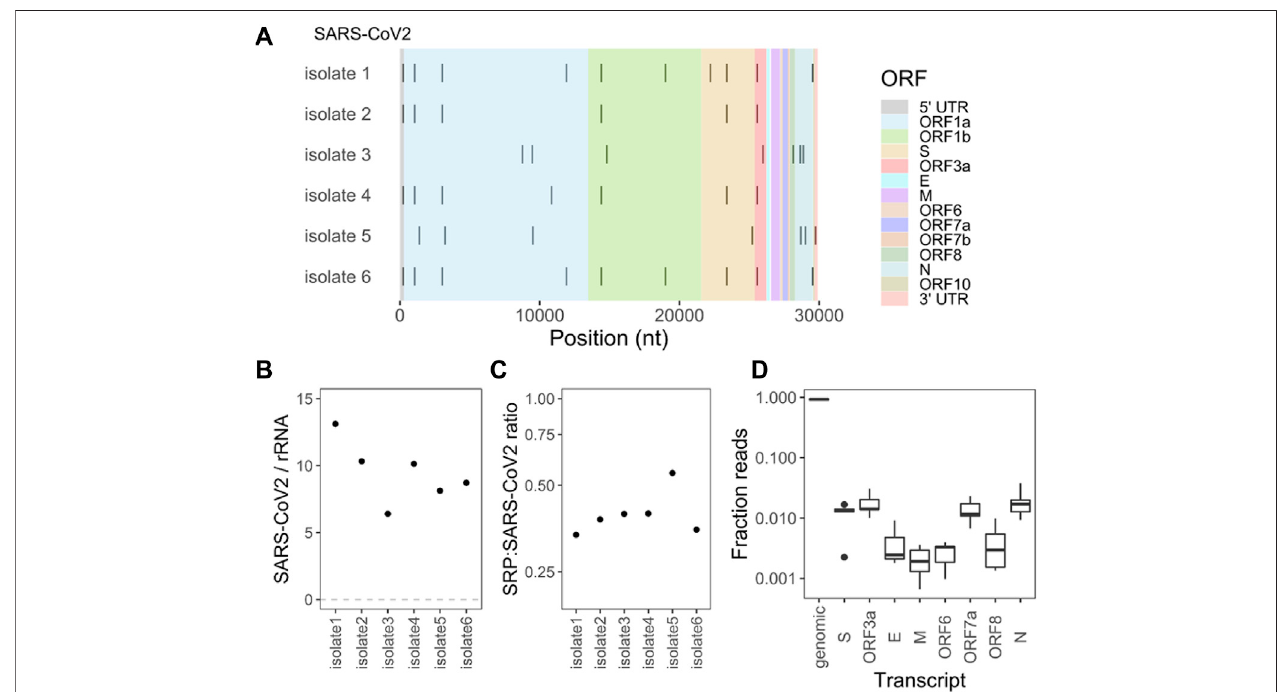
FIGURE 5 | Large RNA sequencing identi fi es viral sequence variants, subgenomic viral RNAs, and signal recognition particle RNA. (A) Single nucleotide polymorphisms (SNPs) for each viral isolate identi fi ed by > 90% mutation fraction from the Wuhan SARS-CoV-2 reference genome. (B) Mapped read count ratio of SARS-CoV2genomicRNAtolarge ribosomal RNA(18Sand 28S) intheviral preparations. (C) NormalizedratioofSRPRNAreads toSARS-CoV-2genomic RNAreads in the viral preparations using the transcript size of 300nucleotides for SRP, and 29,903 nucleotidesfor SARS-CoV-2. (D) Relative fraction ofreads that bridge the junction between the 5 ′ leader region and the genomic RNA (set at 1) and between individual subgenomic RNA. Box and Whisker plot for n = 6 individual isolates.